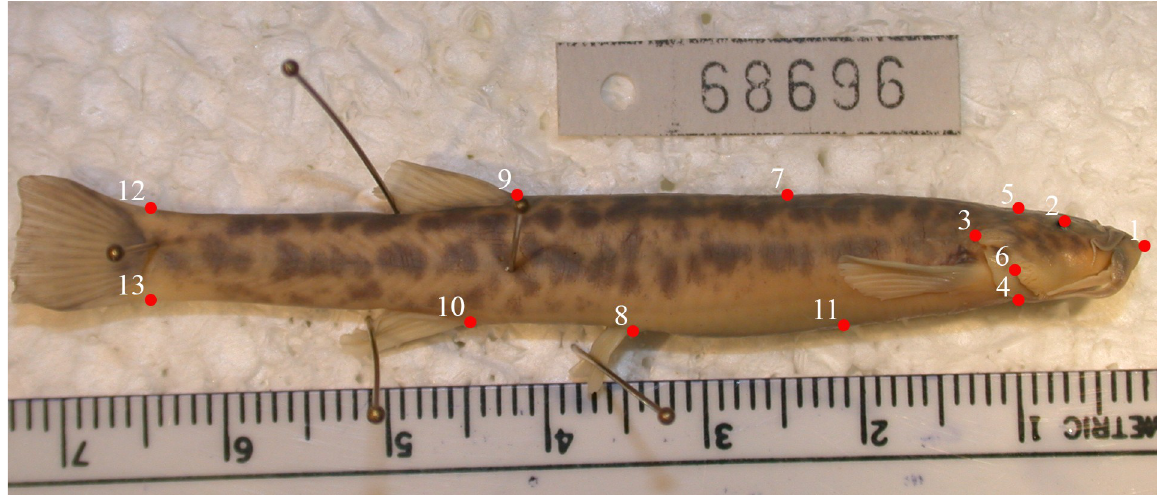
Fig 1. Body landmarks. Landmarks used in the analysis of shape of the lateral body view of T . areolatus